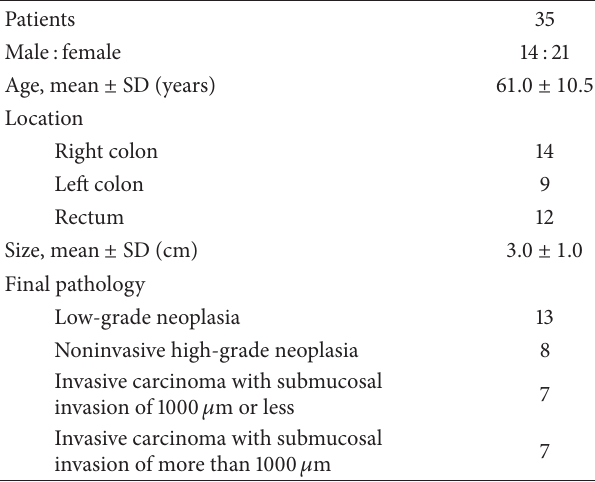
Table 1: Patient characteristics and histopathological features of the